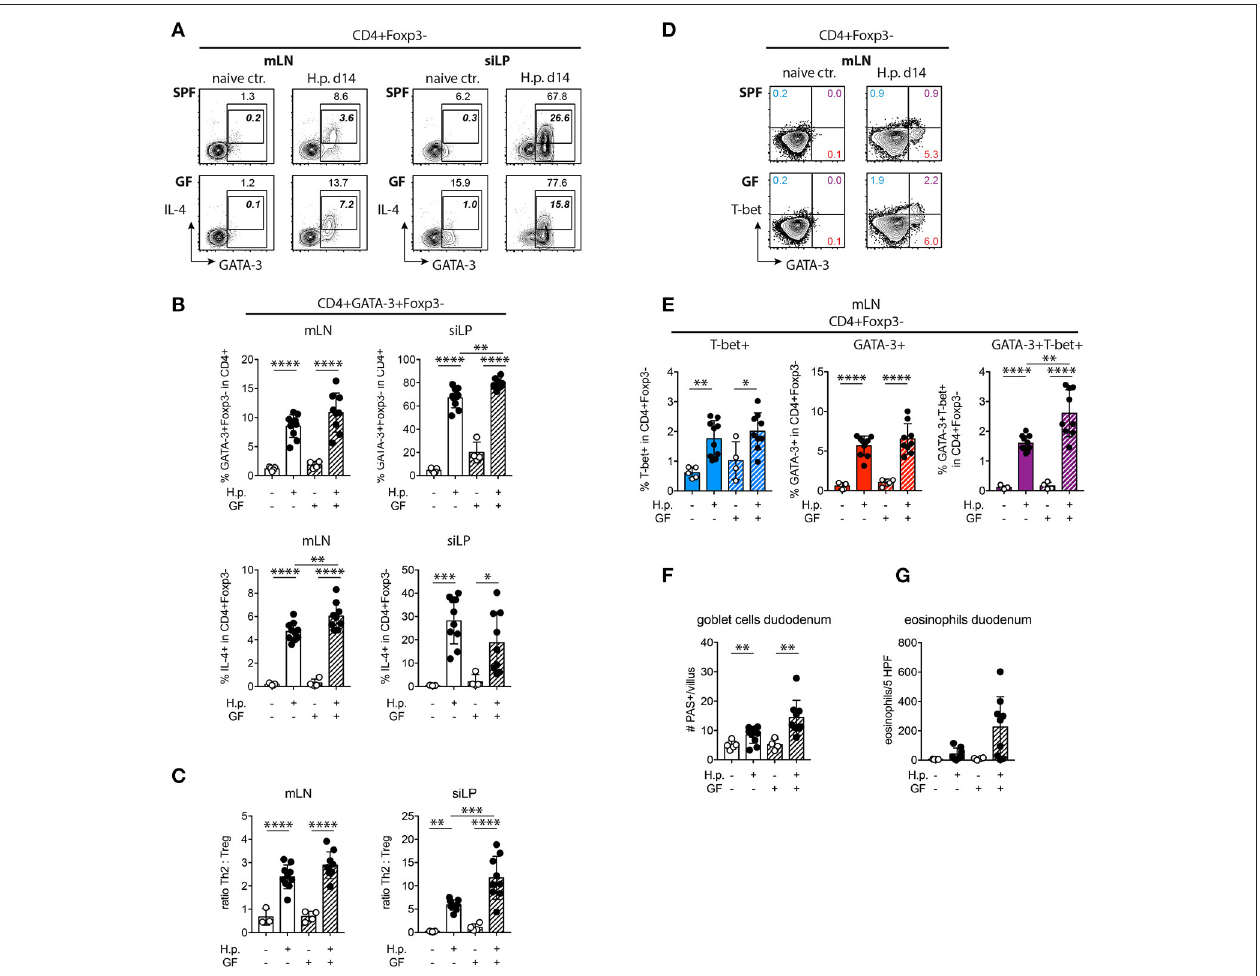
FIGURE 5 | Th2 response and Th2/Treg ratios in SPF and GF mice. (A,B) Representative plots of GATA-3 and IL-4 expression by CD4 + Foxp3 − T cells (A) and frequencies (B) of GATA-3 + and IL-4 + Th2 cells in mLN and siLP. Bold italic numbers in FACS plots refer to IL-4 + cells. (C) Ratios of GATA-3 + Th2 cells to Foxp3 + Treg in mLN and siLP determined based on frequencies in CD4 + T cells. (D,E ) Representative plots of GATA-3 and T-bet expression by CD4 + Foxp3 − T cells (D) and frequencies of T-bet + Th1, GATA-3 + Th2, and GATA-3 + T-bet + Th2/1 cells in mLN (E) . (F,G) Histological goblet cell (F) and eosinophil (G) quantification in the small intestine of naïve and infected mice. Data are pooled from two independent experiments each performed with two to three uninfected and four to five infected mice per group. Mean, SD, and individual data points are shown. * p < 0.05; ** p < 0.01, *** p < 0.001, **** p <